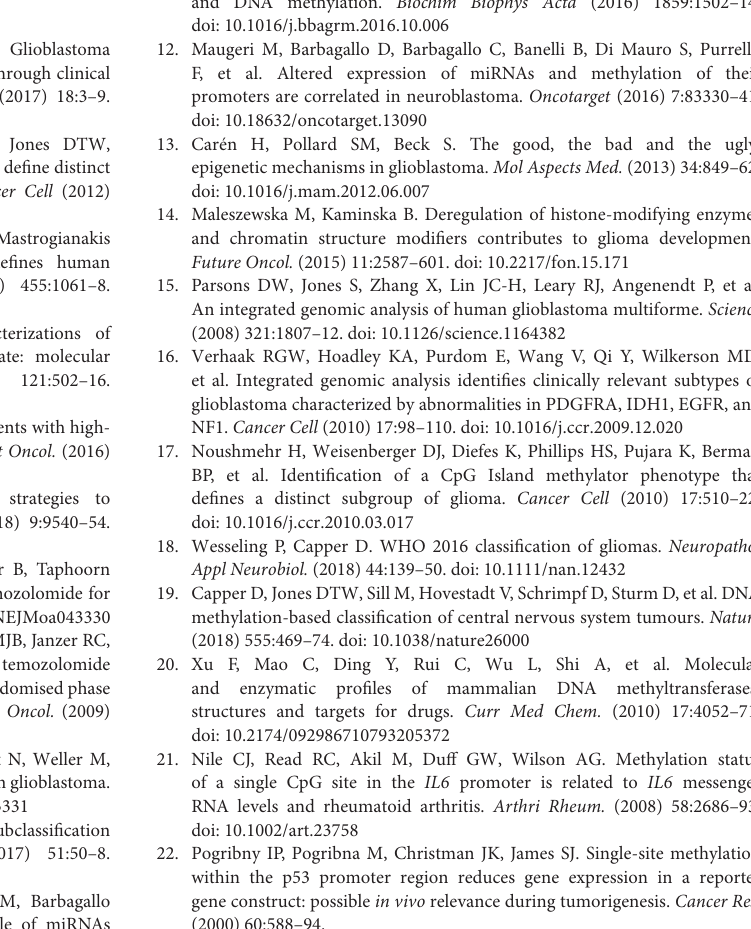
including the histone demethylases JHDM1 and KDM4 and the DNA demethylase TET2 Supplementary Figure 2 | Schematic representation of the major H3 and H4 modifications and their functional role. In green and red the activating and the repressive modifications, respectively. Supplementary Table 1 | Clinical trials employing FDA-approved IDH1/2